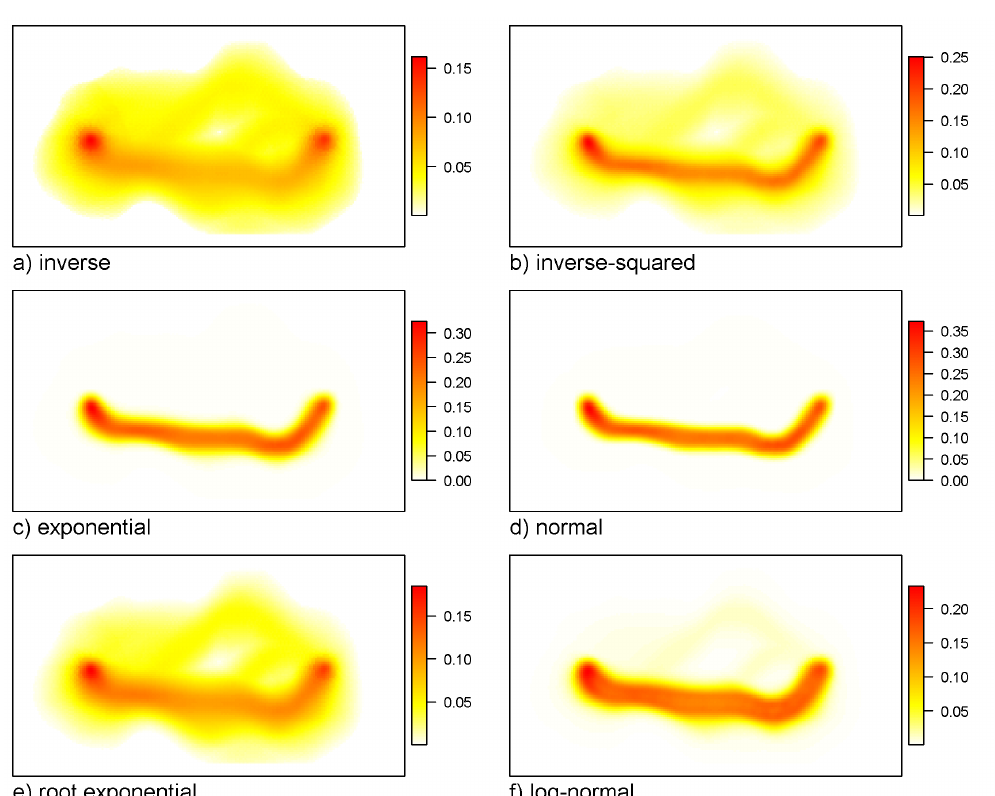
Figure 5: Output probability surfaces ( P i ) from the six potential functions (see Table 3.1) using the field-based time geography model applied to Scenario